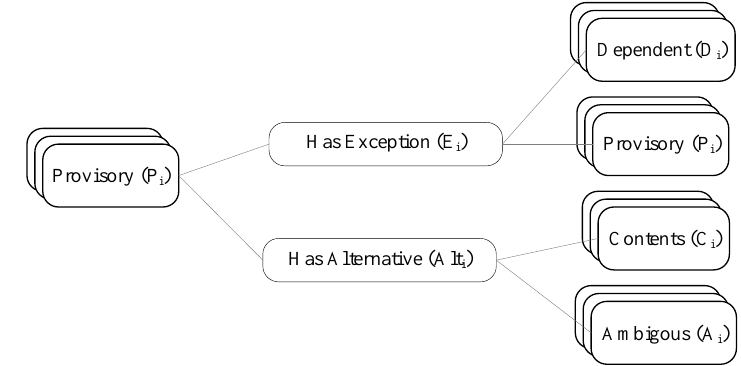
Figure 3. An example of the conceptualization of building regulation provision.